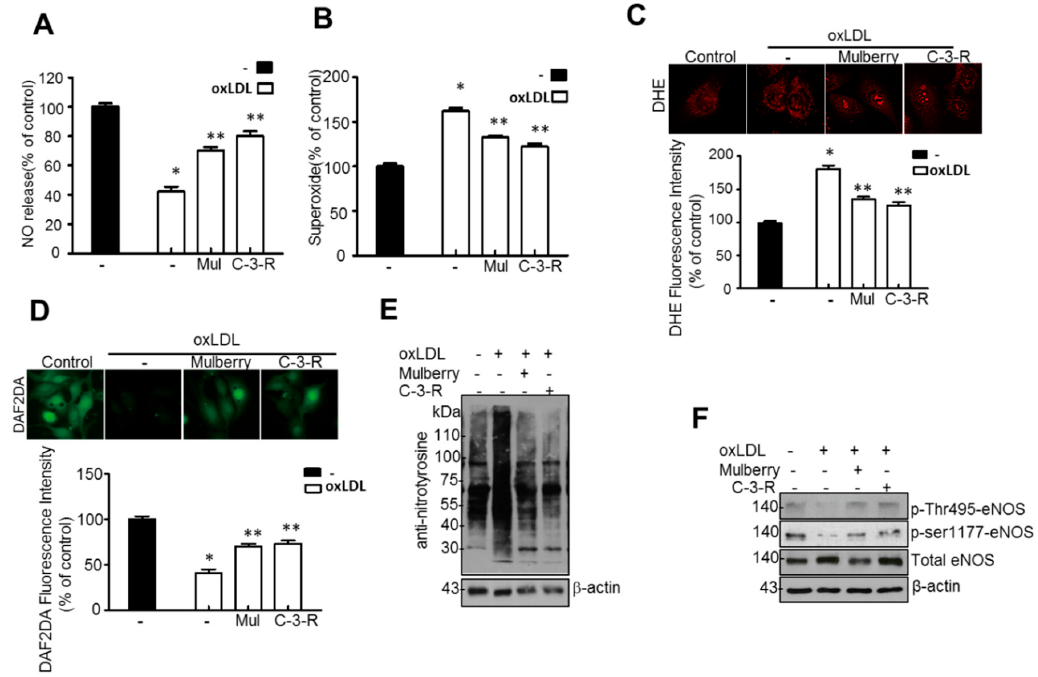
Figure 8. Mulberry improves endothelial cell functions in ox-LDL-treated human umbilical vein endothelial cells (HUVECs). HUVECs were treated with 50 µg/mL C-3-R and 500 µg/mL mulberry, then incubated with 20 µg/mL ox-LDL for another 24 h. NO production ( A ) and endothelial O 2- production ( B ) were assessed as described in the materials and methods. Values are presented as mean ± SEM. ( n = 3; * p <0.05 versus control; ** p <0.05 vs. ox-LDL) ( C ) Representative images of DHE staining for O 2- production. Values are presented as mean ± SEM. ( n = 3; * p <0.05 versus control; ** p <0.05 vs. ox-LDL) ( D ) Quantification of DHR fluorescence intensity for peroxynitrite levels. Values are presented as mean ± SEM. ( n = 3; * p <0.05 versus control; ** p <0.05 vs. ox-LDL). Nitrotryosine ( E ) and expression of β -actin in HUVECs were determined by Western blotting. Phosphorylation of eNOS at Thr495 and Ser1177 ( F ) and expression of total eNOS and β -actin in the HUVECs were determined by Western blotting. HUVEC, human umbilical vein endothelial cells; C-3-R, cyanidin-3- rutinoside; ox-LDL, oxidized low-density lipoprotein; NO, nitric oxide; DHE, dihydroethidium; DHR, dihydrorhodamine.